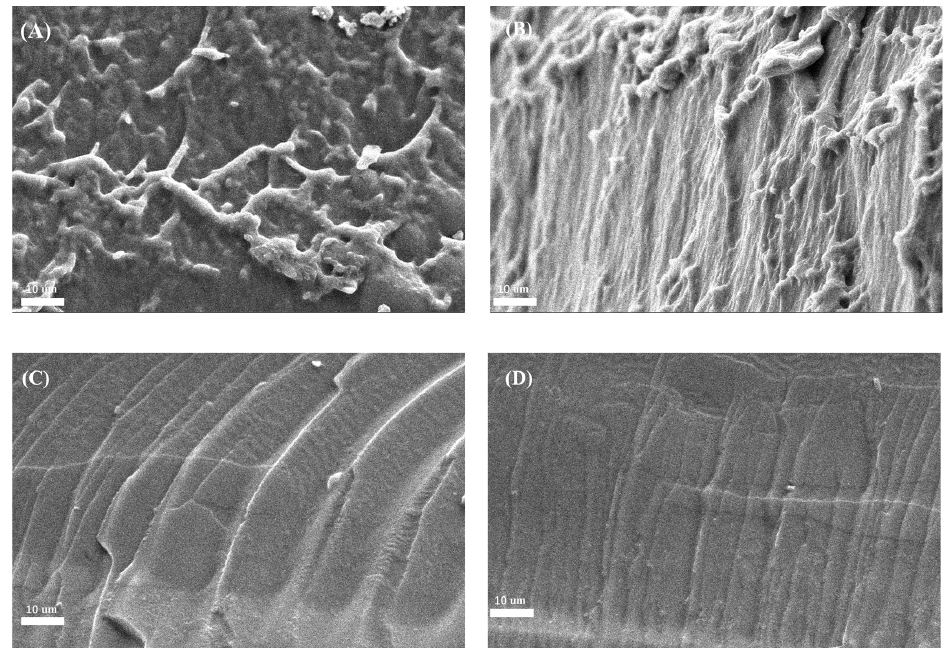
Figure 4. FE-SEM images of the fracture surfaces of ( A ) unmodified SSPS; ( B ) SPC; ( C ) SPC-O; ( D ) SPC-Fe(III) composite films.